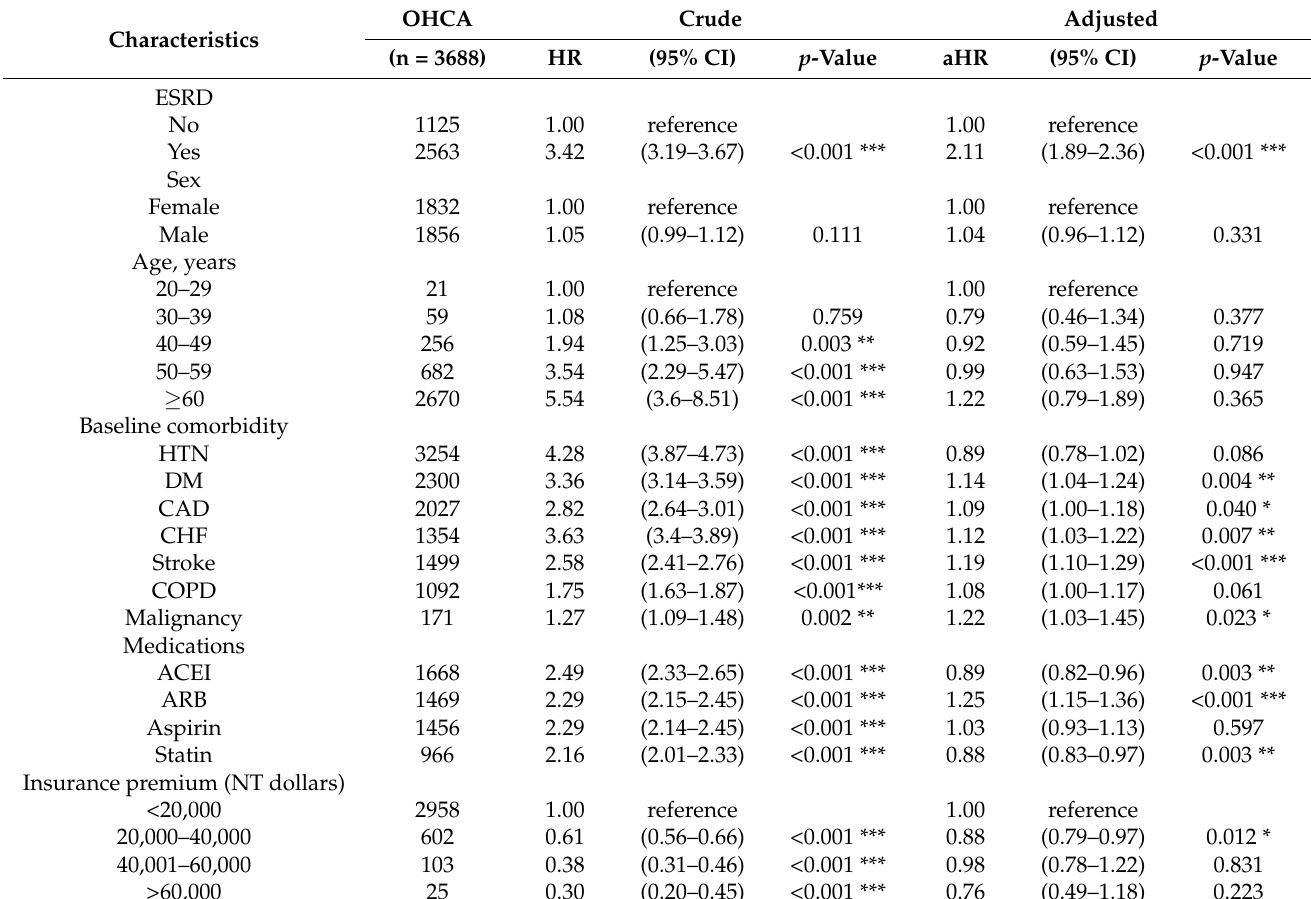
Table 2. The Cox regression model to measure the crude and adjusted hazard ratio and 95% confi- dence intervals of incidence of OHCA between the ESRD and non-ESRD